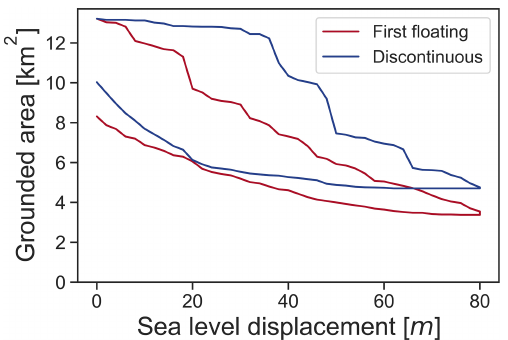
Figure B1. Shown is the response of the grounded area in the low-friction case of the first floating (red) and discontinuous (blue) Elmer/Ice numerical grounding line implementations.